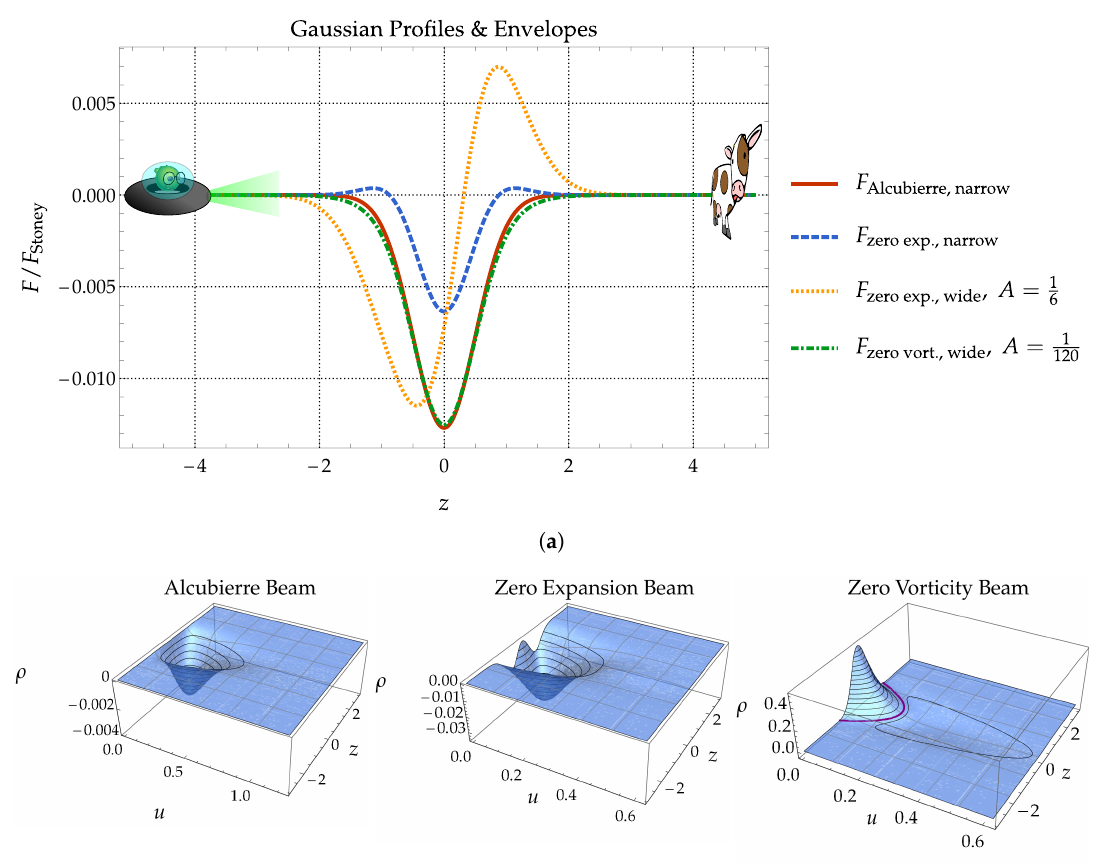
Figure 1. ( a ) Forces F and ( b ) energy densities ρ for Gaussian beam profiles. The field is assumed to be sourced by someone on the left at negative z , the target—a flat cow in the tractor field space-time—on the right at positive z . Choosing the source and target provides for a distinction between tractor and pressor (or repulsor) fields. Details concerning this particular beam configuration can be found in Section 6.2.1. The parameters of Equation (186) that we have chosen are: A = 0.5 and B = C = 1.0. The purple line in the density plot for the zero-vorticity beam indicates the location where the energy density is